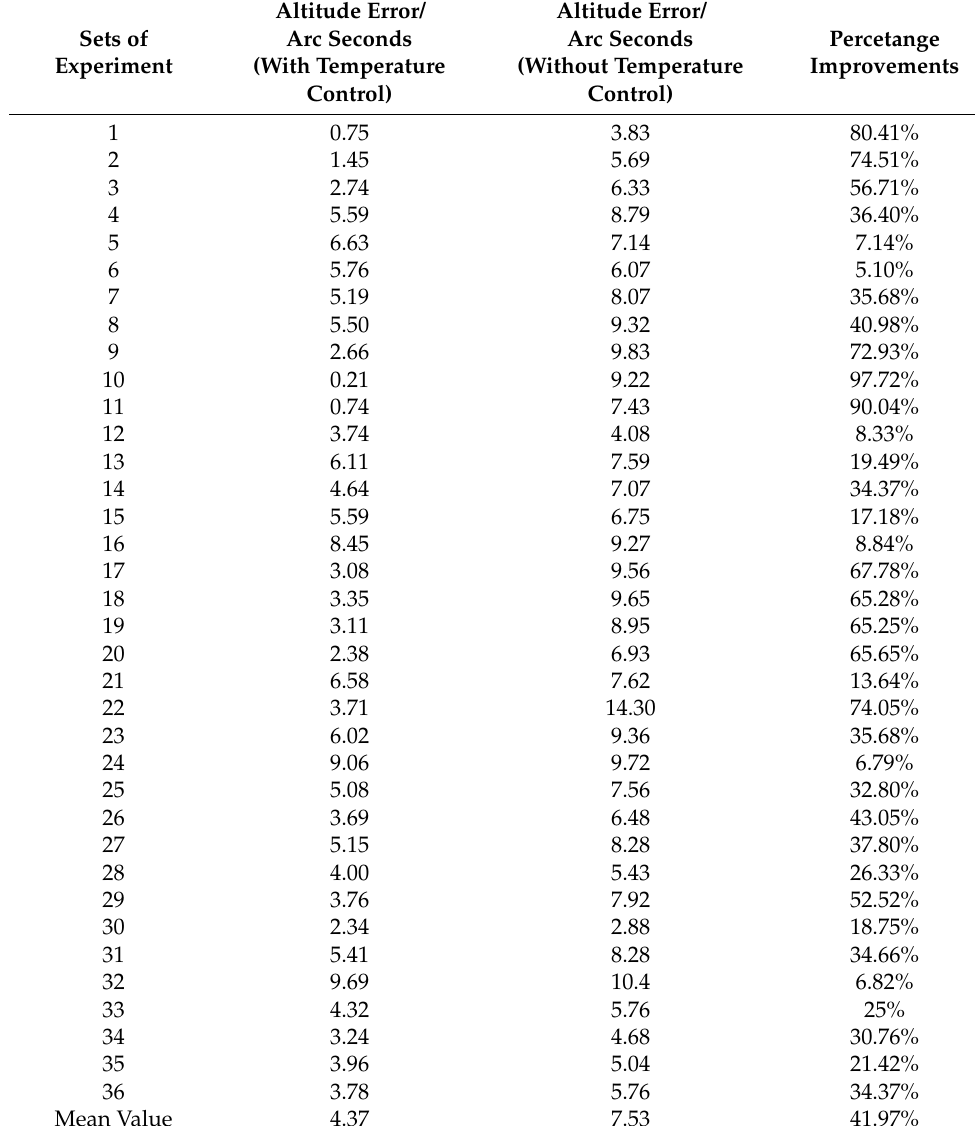
Table 7. Altitude errors of yaw